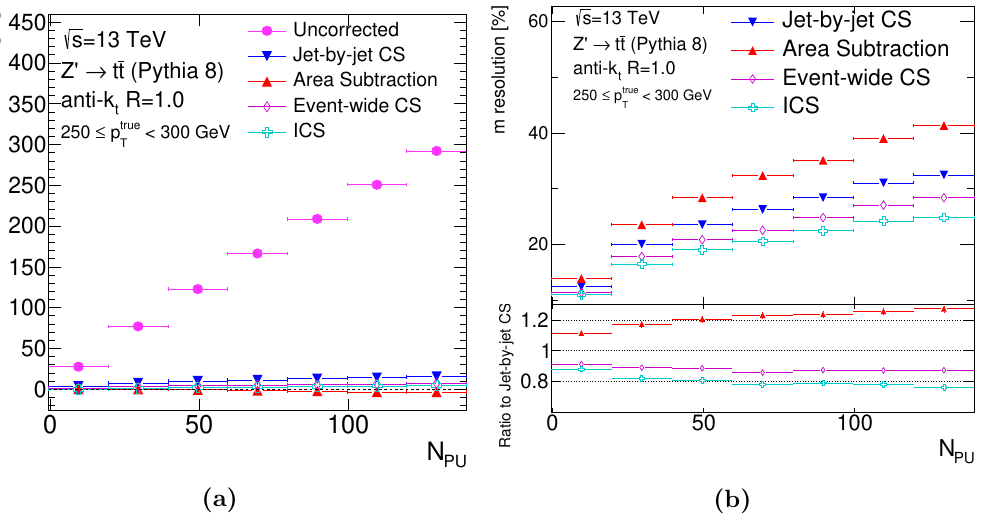
Figure 3. Dependence of jet mass bias (left) and resolution (right) on N PU for four pileup correction methods (Jet-by-jet CS, Area Subtraction, Event-wide CS, and